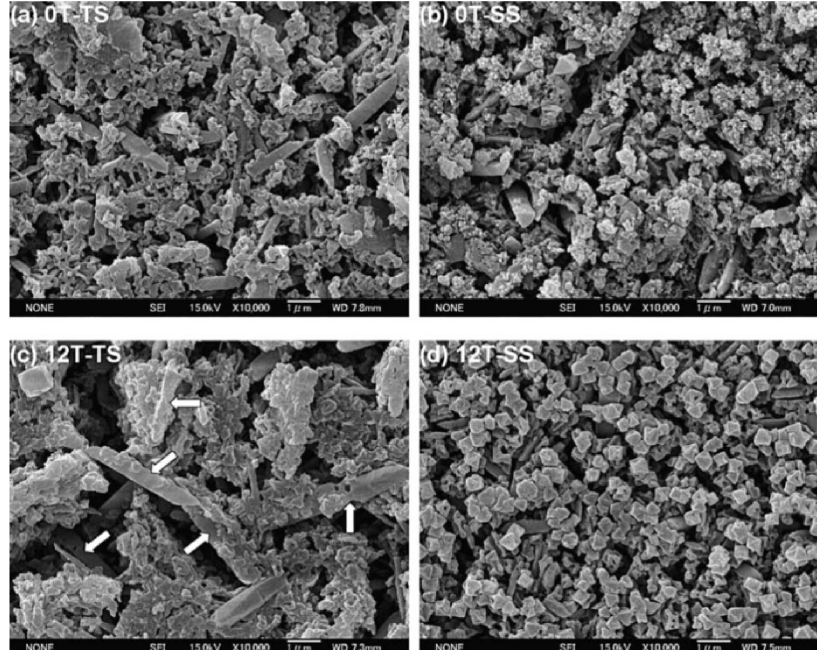
Fig. 30 Polished and molten NaOH-etched surface morphologies of Ca–α-SiAlON ceramics: (a, b) top surface ( ⊥ casting) and side surface (// casting) of 0 T specimen, respectively; (c, d) top surface ( ⊥ B ) and side surface (// B ) of 12 T specimen, respectively. White arrows indicate these oriented rodlike grains. Reproduced with permission from Ref. [227], © The Ceramic Society of Japan